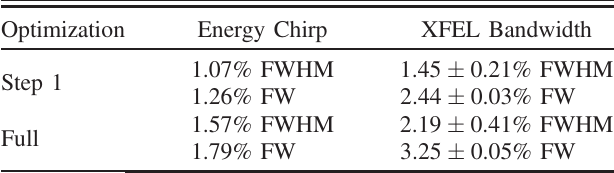
TABLE I. Energy chirp and XFEL pulse bandwidth including the statistical errors for SwissFEL. Two different cases are presented: after the optimization of the compression scheme (step 1) and after the full optimization procedure, which includes the optimization of the compression scheme of the machine and of the electron distribution at the source.